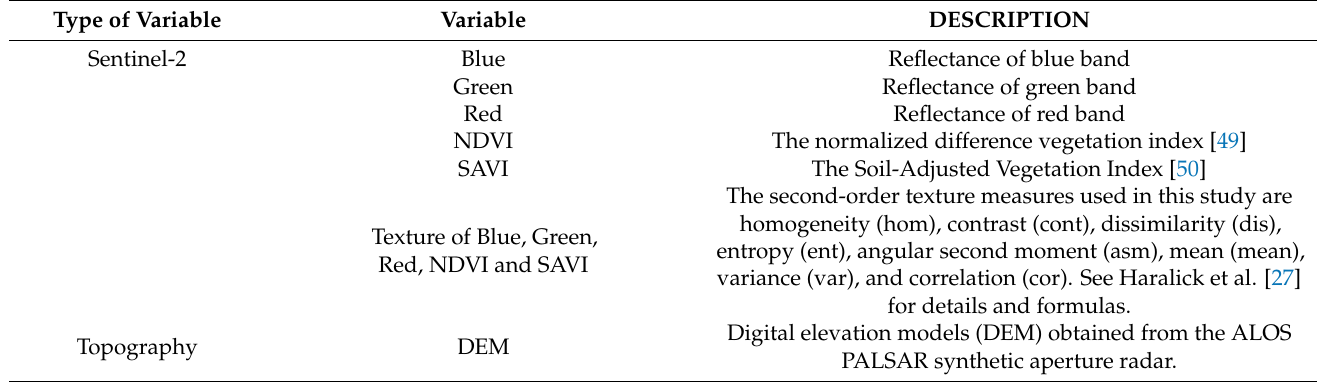
Table 1. Description of explanatory variables used to estimate species richness and functional